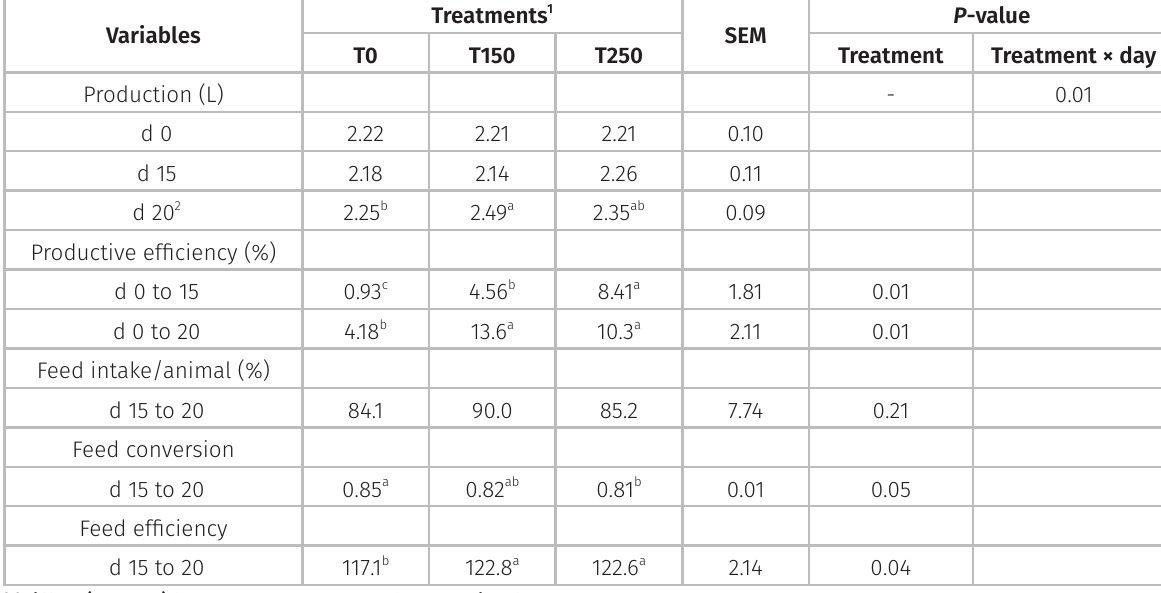
Table II. Milk performance of Lacaune ewes supplemented with dietary phytogenic.